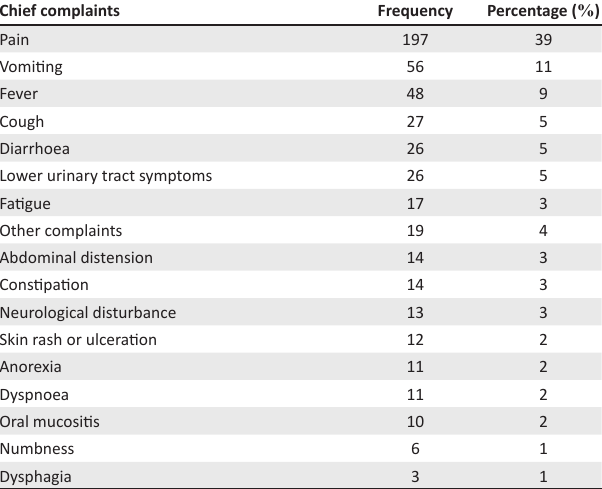
TABLE 3: Distribution of patients according to sites and types of